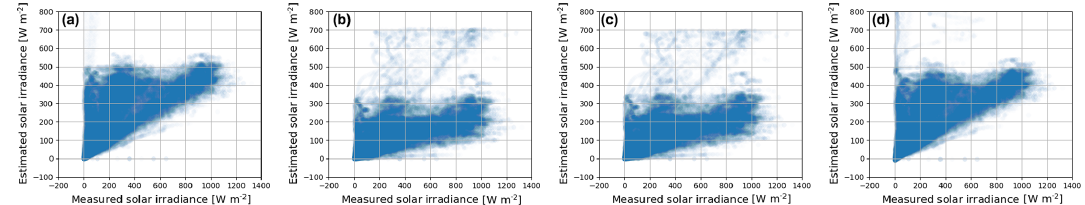
Figure 12. Scatter plot between measured solar irradiance and estimated solar irradiance for the benchmarking algorithms. (a) Hargreaves and Samani (1985). (b) Donatelli and Campbell (1998). (c) Bristow and Campbell (1984). (d) Hunt et al. (1998).